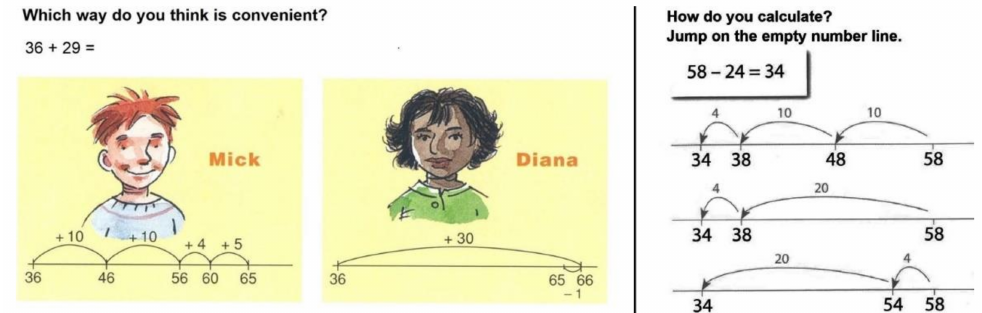
Figure 12. Stringing and varying calculation strategies on the empty number line in PP2 (2000s, left, Grade 3, lesson book p. 9) and WiG4 (2010s, right, Grade 2, student book p.